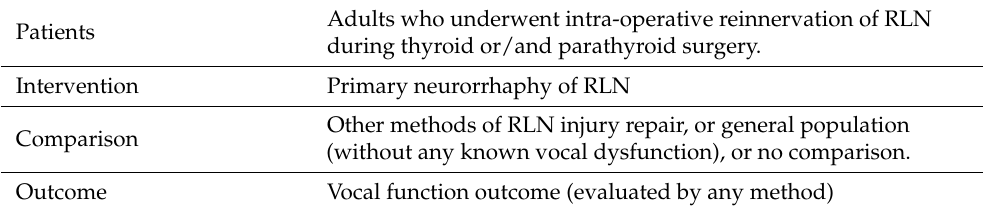
Table 2. PICO strategy for the literature